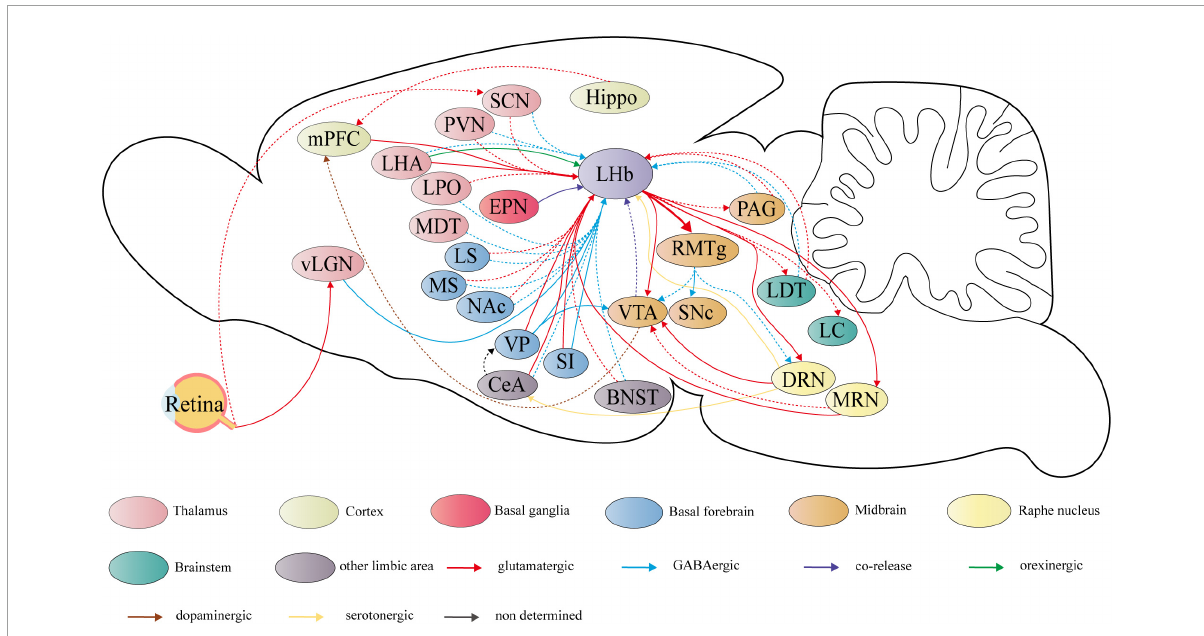
FIGURE2 Summary schematic of neural circuits linking the lateral habenula (LHb) to the pathophysiology of depression. The circuits have experimentally proven to regulate depressive-like behaviors, including anhedonia, social disorder, passive coping, and aggressive behaviors are represented by the solid line. Dashed lines represent potential functional circuits, but there is insufficient clear experimental evidence to determine the regulatory role in depressive-like behaviors. LHb receives primarily glutamatergic input (shown in red) and GABAergic inputs (shown in blue). The first source is hypothalamic structures, including the lateral hypothalamic area (LHA), paraventricular nucleus (PVN), suprachiasmatic nucleus (SCN), lateral preoptic area (LPO), and the medial dorsal thalamic nucleus (MDT). The second is the basal forebrain, including the ventral pallidum (VP), nucleus accumbens (NAc), substantia innominate (SI), medial septum (MS), and lateral septum (LS). Other limbic areas, such as central amygdala (CeA), and bed nucleus of the stria terminalis (BNST) are also the sources of LHb input. The medial prefrontal cortex (mPFC) also projects directly to the LHb. Furthermore, LHb receives glutamate/GABA co-releasing projections (shown in purple) from the entopeduncular nucleus (EPN) located in the basal ganglia and GABAergic projections from the thalamic ventral lateral geniculate nucleus–intergeniculate leaflet (vLGN–IGL) located in the visual thalamic region. The vLGN–IGL and the SCN can receive light signaling from retina cells. LHA also sends orexinergic projection (shown in green) to LHb. Based on the strong glutamatergic projections to the rostromedial tegmental nucleus (RMTg), LHb forms a complex network of projections to both dopaminergic nuclei and the raphe nucleus, which the former comprises the ventral tegmental area (VTA) and substantia nigra pars compacta (SNc), and the latter comprises dorsal raphe nucleus (DRN) and median raphe nucleus (MRN). Dopaminergic and serotonergic projections are shown respectively in brown and in yellow. Furthermore, LHb sends glutamatergic projection to the periaqueductal gray (PAG), laterodorsal tegmental nucleus (LDT) and locus coeruleus (LC) and receives feedback projections from these regions. Hippocampus (Hippo), which is strongly related to depression, shows a potential connection with